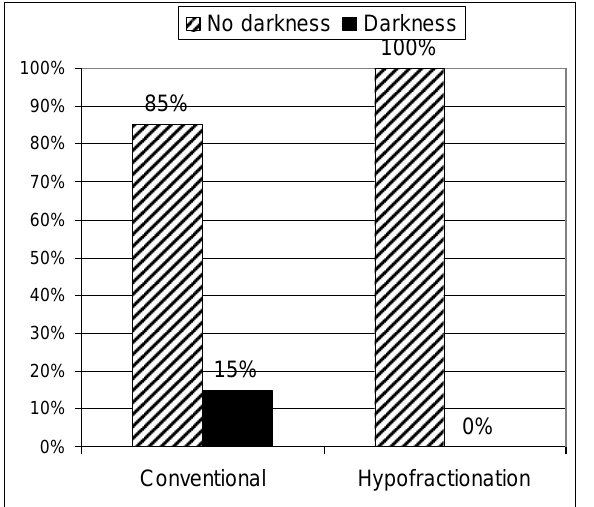
Figure 5: The rate of dry desquamation (conventional vs. hypofractionated radiotherapy)